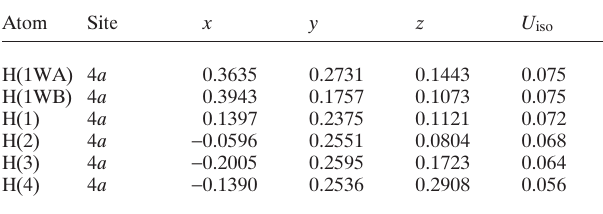
Table 2. Atomic coordinates and displacement parameters (in Å 2 )